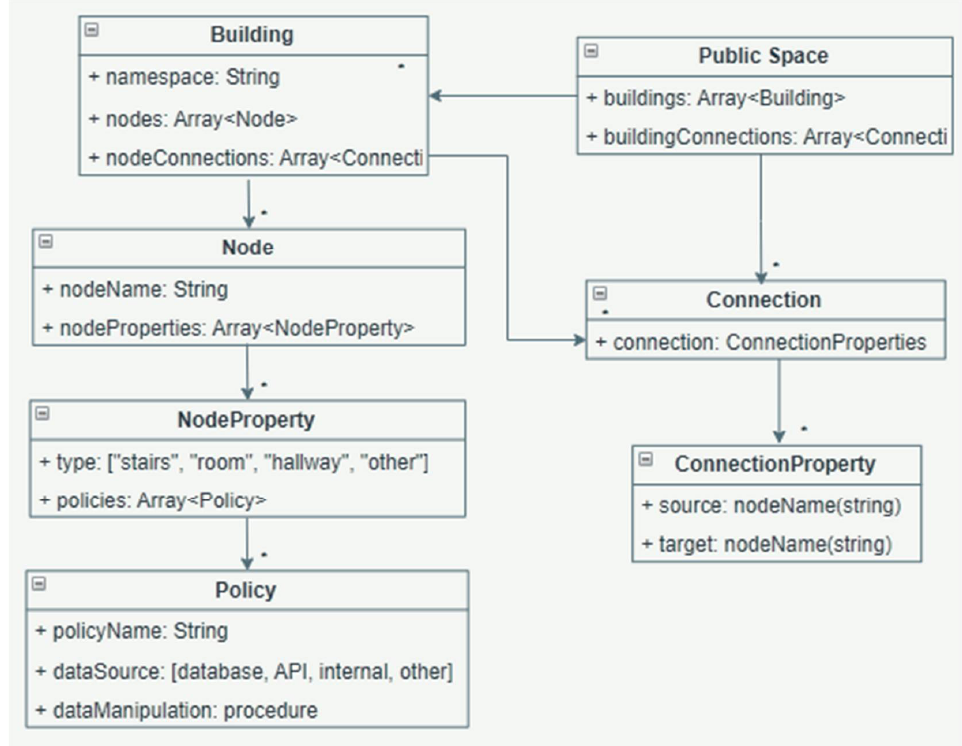
Figure 3. Building graph model with policies attached.